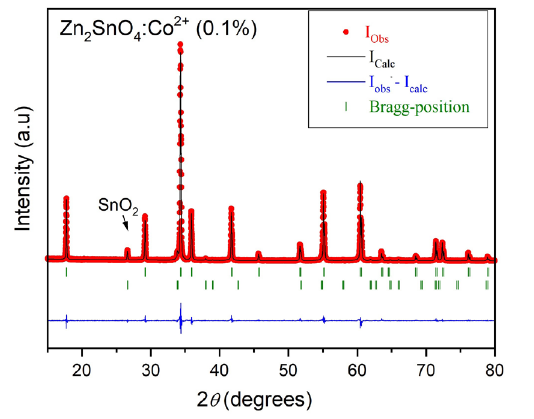
Figure 4. X-ray diffraction and Rietveld refinement data for the Zn2SnO4:Co 2+ (0.1%) sample.